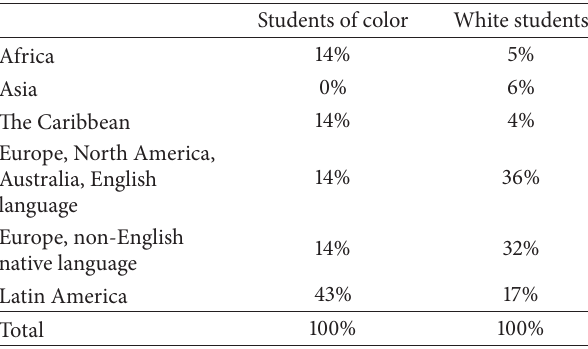
Table 5: Study abroad destinations for